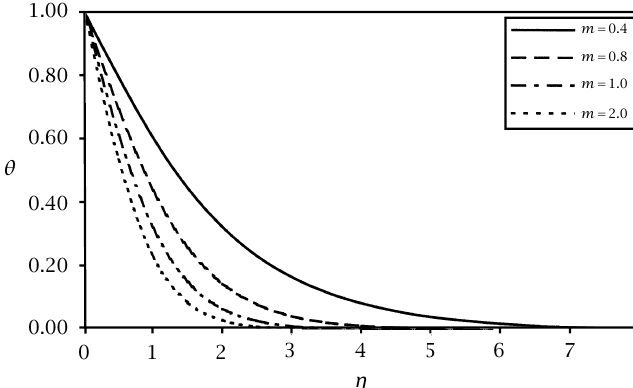
Figure 3.6 . The variation of θ against η for M = 0 . 2 and R = 1.